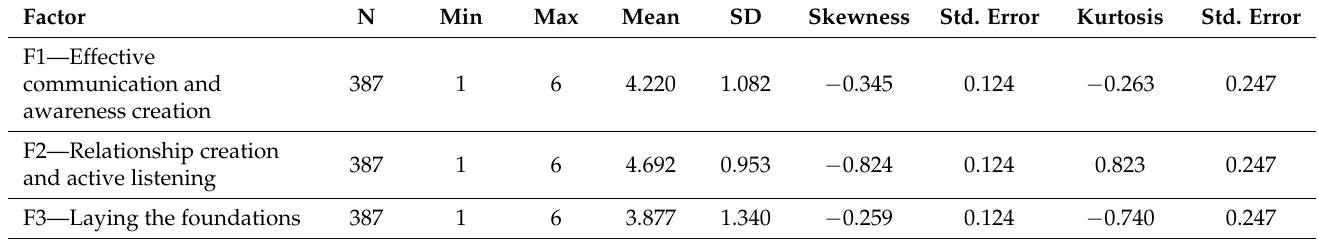
Table 2. Descriptive statistics.